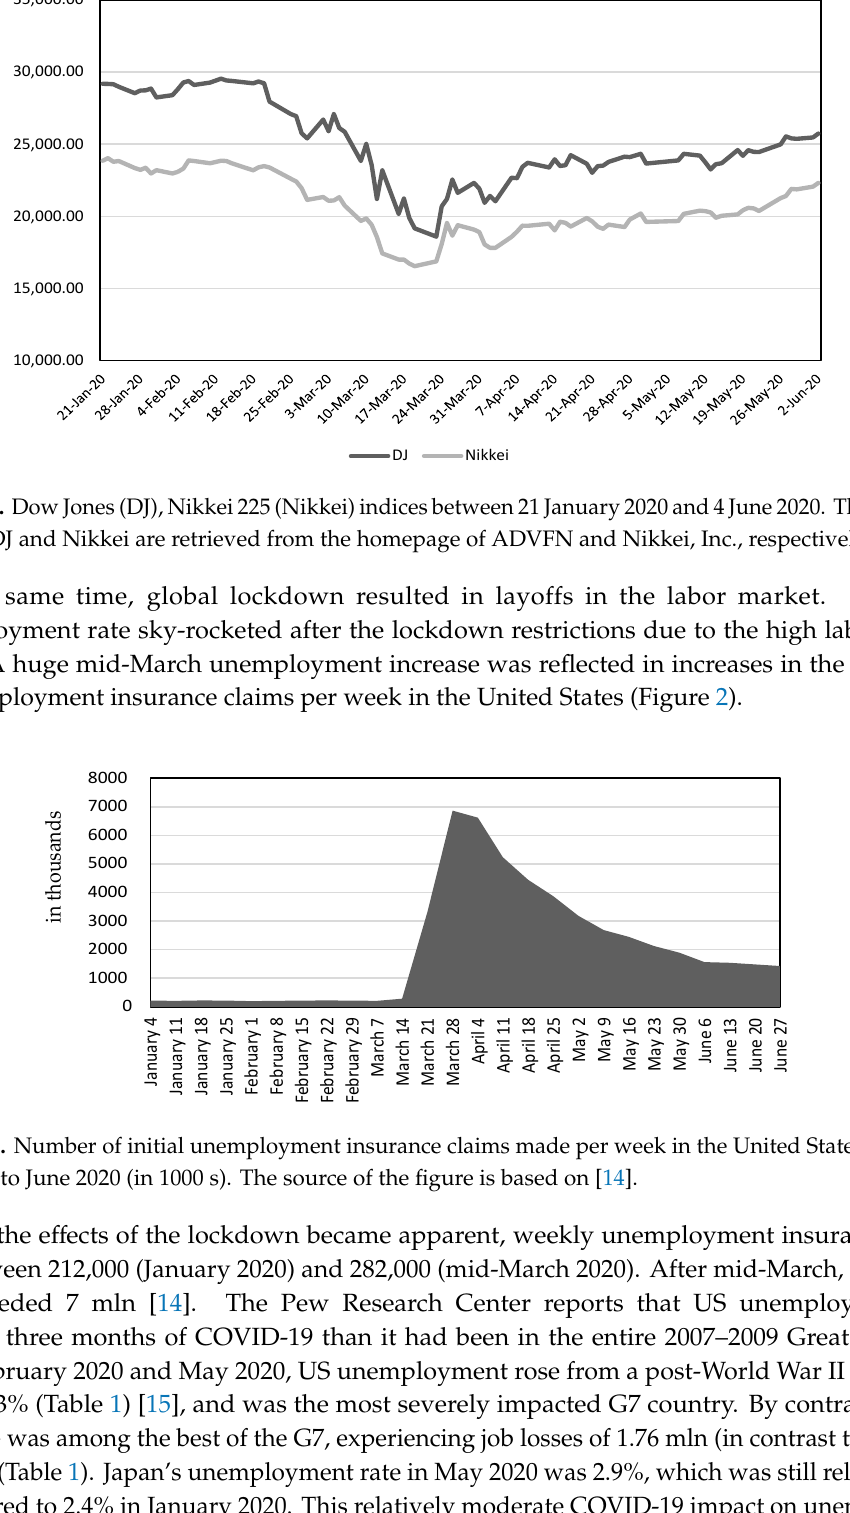
is, however, at least partially explained by Japan’s ongoing struggle with deflation, combined with a decreasing population that encourages companies to keep employees rather than laying them o ff